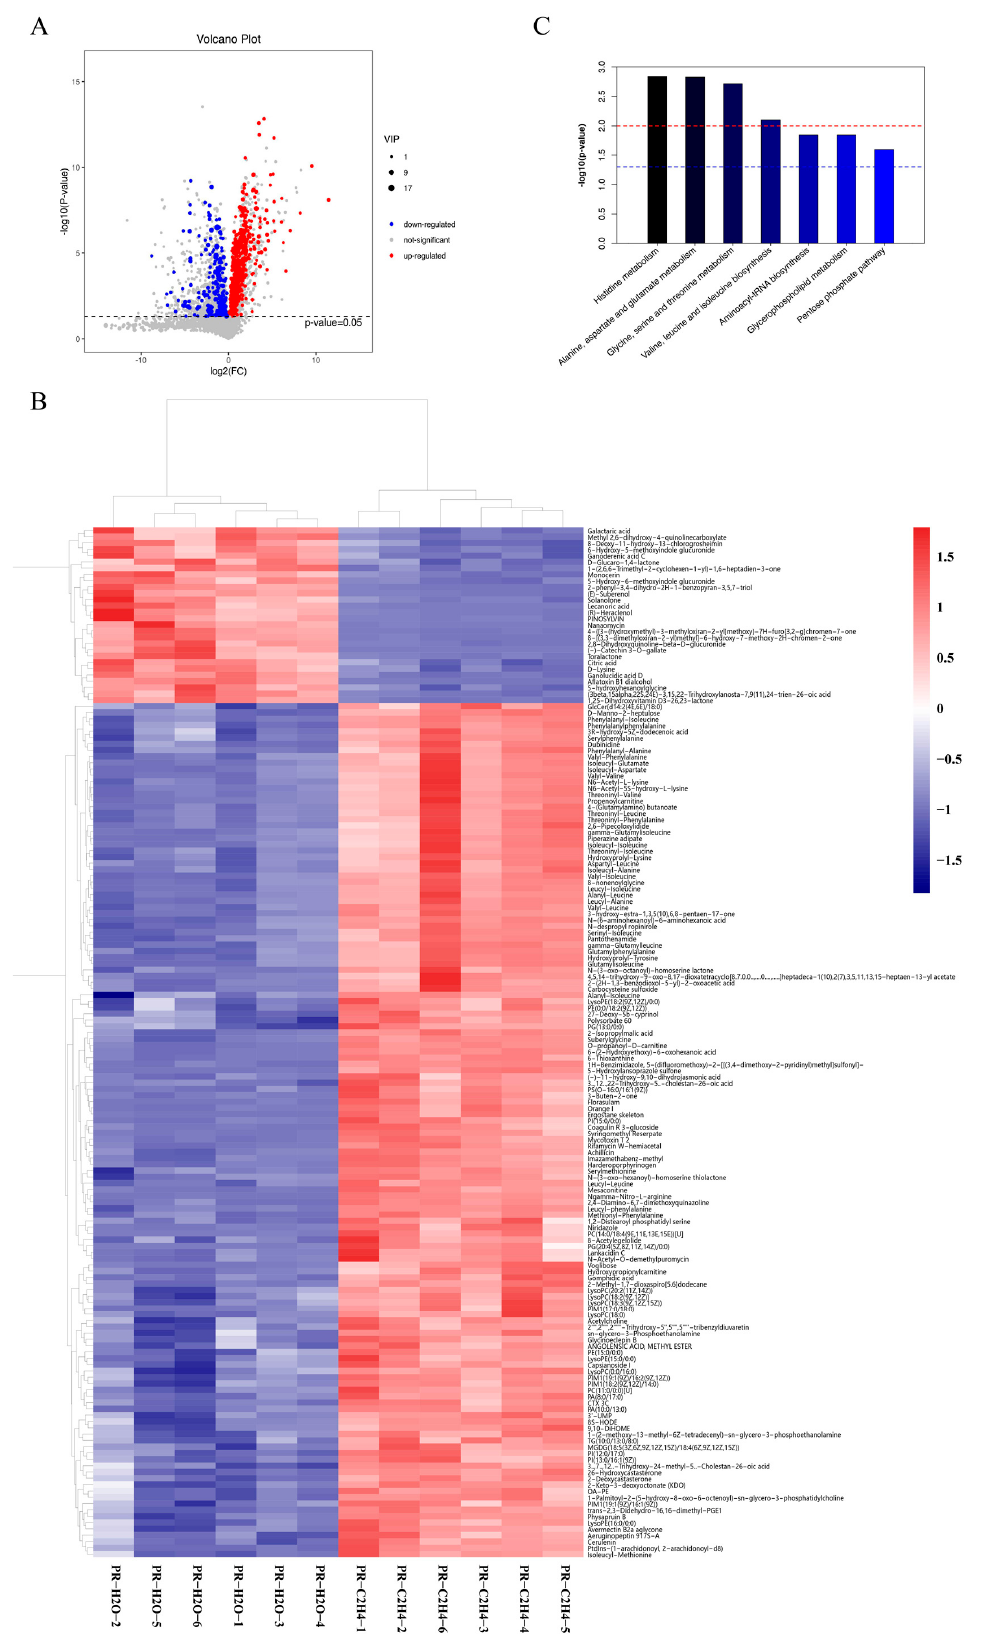
1 Figure 3. The differentially accumulated metabolites in response to ethylene . ( A , B ) are volcano plots and clustering heat map of differentially accumulated metabolites. The metabolite content